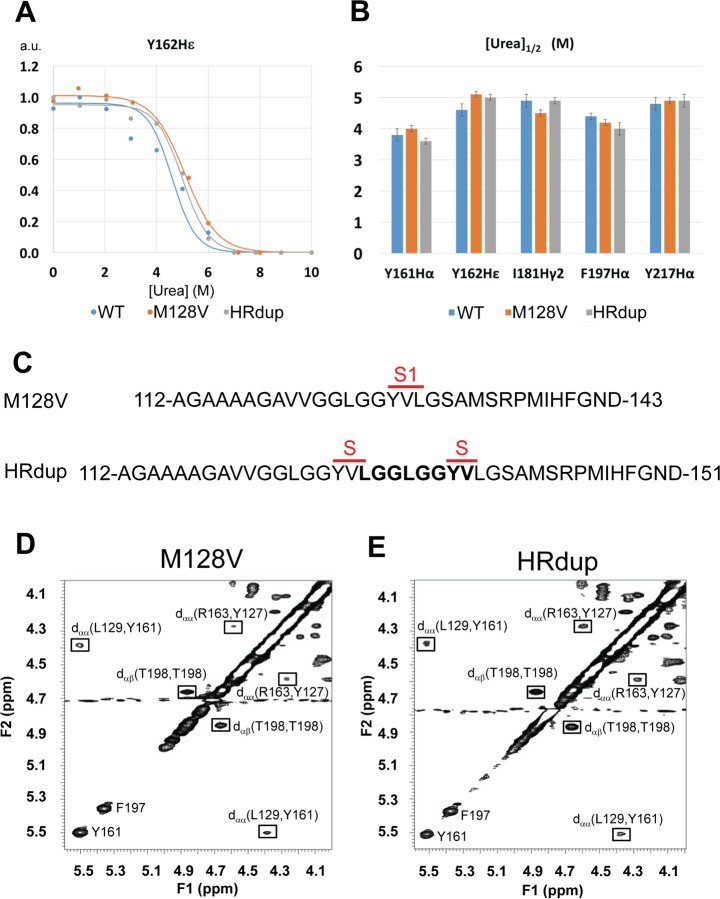
NMR spectra and beta-sheet signatures of recombinant proteins.A) Representative urea titration of one (Y162) of five assayed residues positioned in PrP's globular domain, as assessed for three PrP constructs (as indicated). B) Half maximal urea concentrations of each of the five residues with allelic origin color code as per panel A and presented with residues in numerical order. No pair-wise comparisons between the same residue measured in the three alleles reached significance. C) Position of beta strand S1 in WT PrP (top line) and a potential, additional beta strand, both indicated by S, that might arise as a consequence of the tandem duplication encompassing the residues YVLG. Lower panels; Part of the 2D 1H-1H NOESY spectra of M128V (D) and HRdup (E) where NOEs due to the presence of β-sheet are displayed.